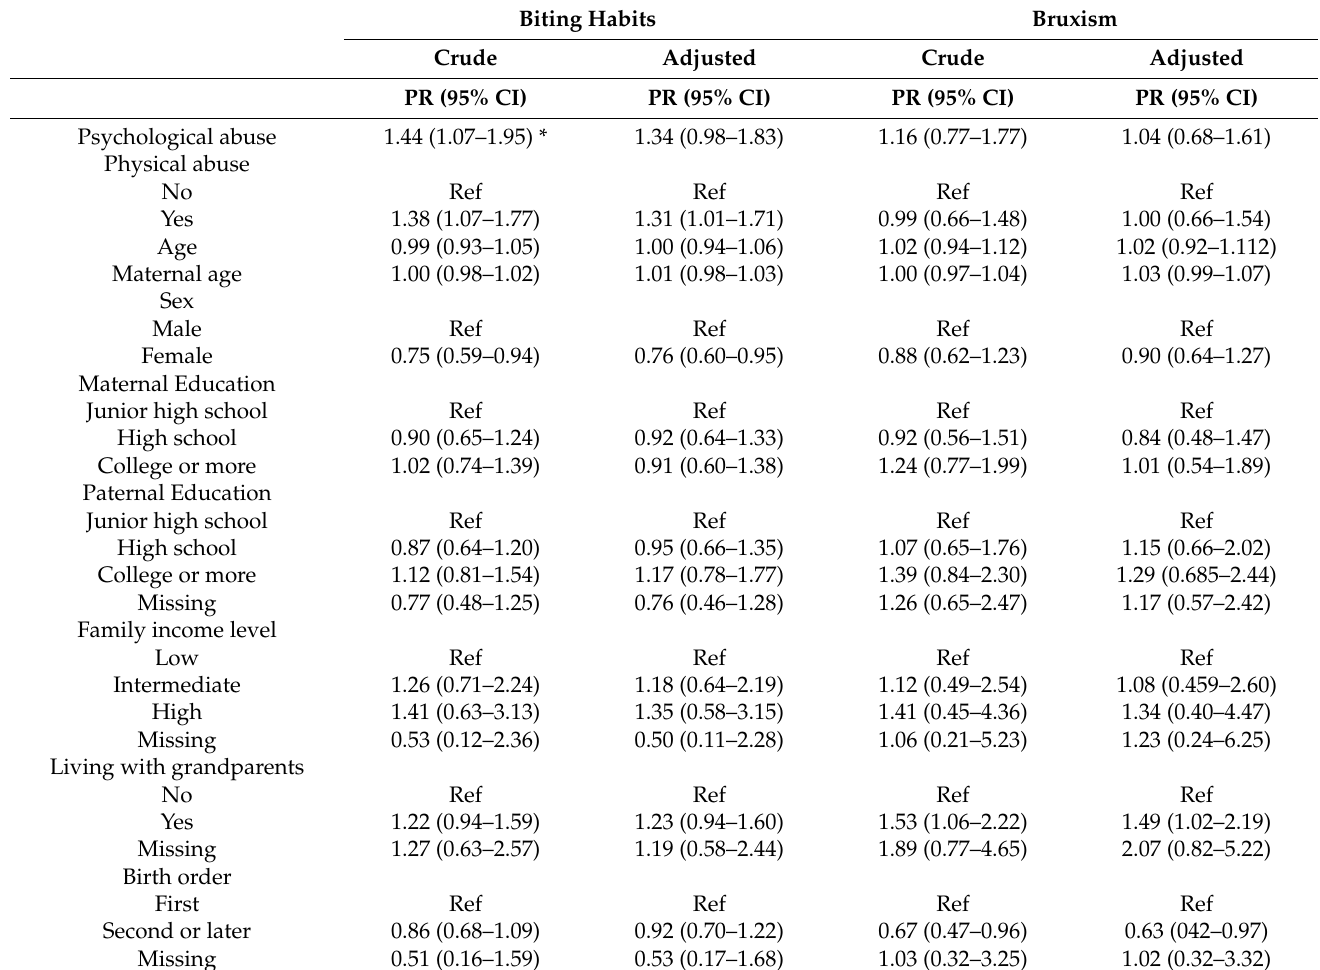
Table 3. Associations between psychological abuse and oral habits (N = 761 a ). Biting Habits